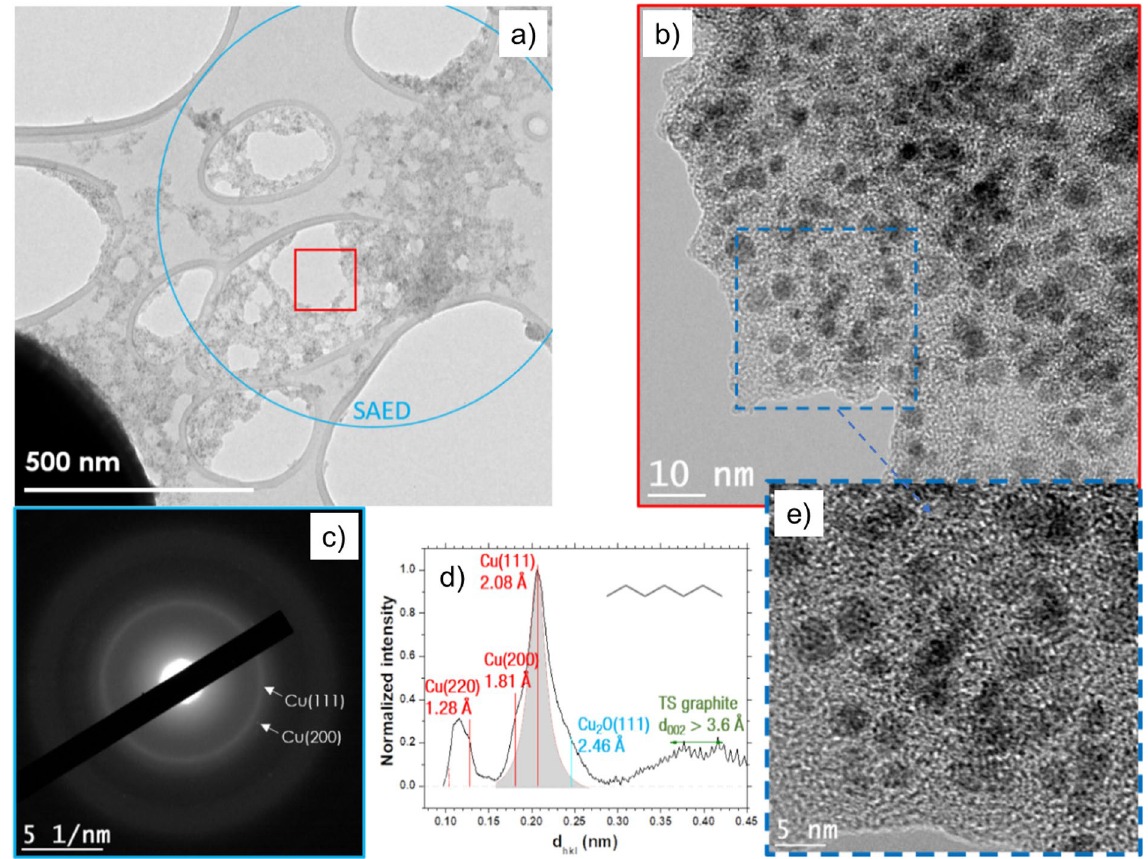
Figure 6. ( a ) High-resolution image of Cu nanoparticles embedded in a carbonaceous matrix synthesized by discharges in heptane. ( b ) HRTEM image of the red inset of ( a ) showing Cu nanoparticles (black) and nanocrystalline carbon ( e ) is a magnification of the dashed blue square in ( b ). ( c ) SAED pattern from ( a ) radially integrated into ( d ). The Cu (111) integrated band is fitted in gray to highlight the presence of a faint cuprite Cu 2 O (111)